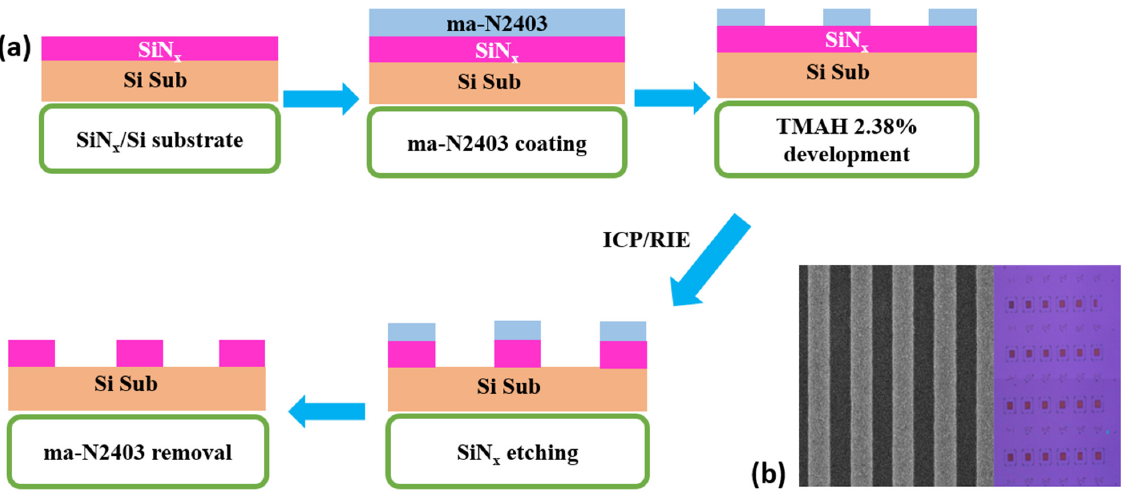
Figure 1. ( a ) SiN x 1-D photonic crystal fabrication steps. For transferring the pattern, ICP/RIE etching technology was used. ( b ) SEM image and optical microscope image of the SiN x 1-D PhC.